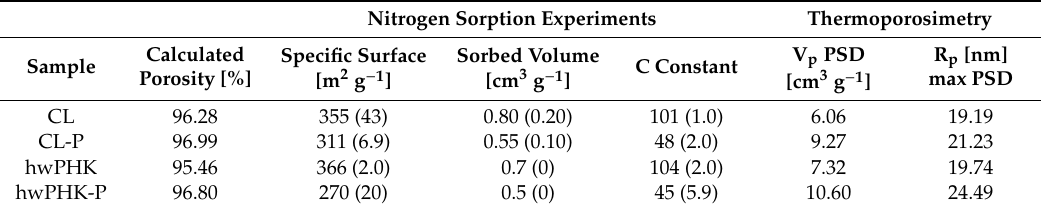
Table 4. Calculated porosity, results of nitrogen sorption experiments and pore characteristics derived from thermoporosimetry. Numbers in brackets indicate the 95% confidence interval ( n = 3).